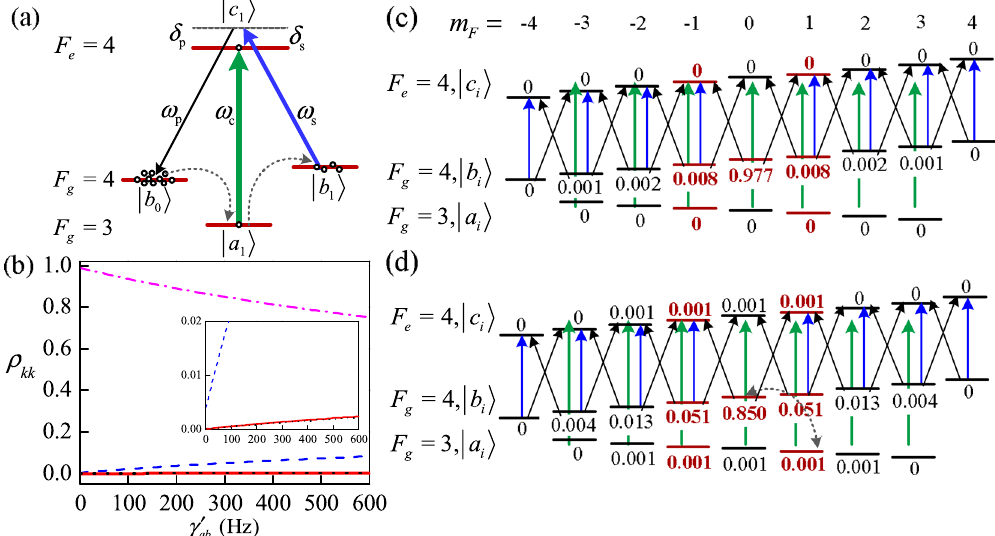
Figure 1. ( a ) The simplified field-atom system. Green, blue and black lines designate the coupling, pumping- signal and weak probe fields, respectively. ( b ) Population ρ kk vs γ ′ dot (black) curves for ρ ( c , d ) The Zeeman sublevels with ToP rate γ ′ Ω c = 20 MHz, Ω s = 8 MHz, δ c = 0, δ s = 10 MHz, γ γ ′ = ′ = 20Hz